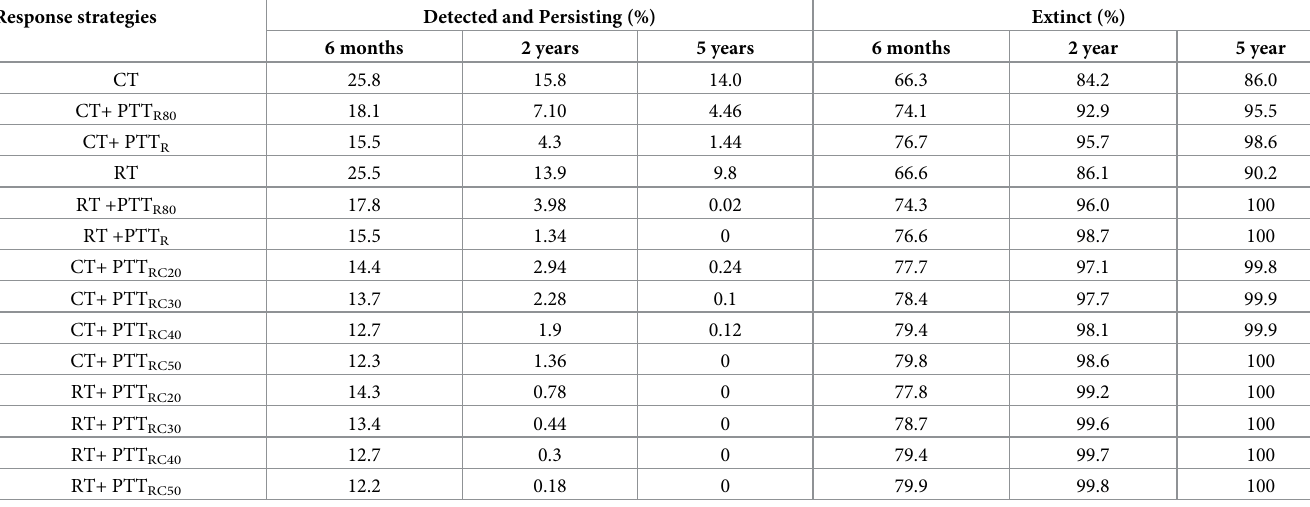
Table 3. Proportion of simulations in which the imported strain was detected and persisting, or extinct at 6 months, 2 years and 5 years post-importation. Response